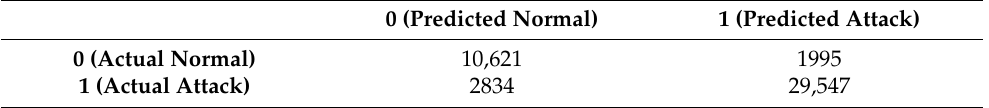
Table 3. Confusion matrix of BR algorithm